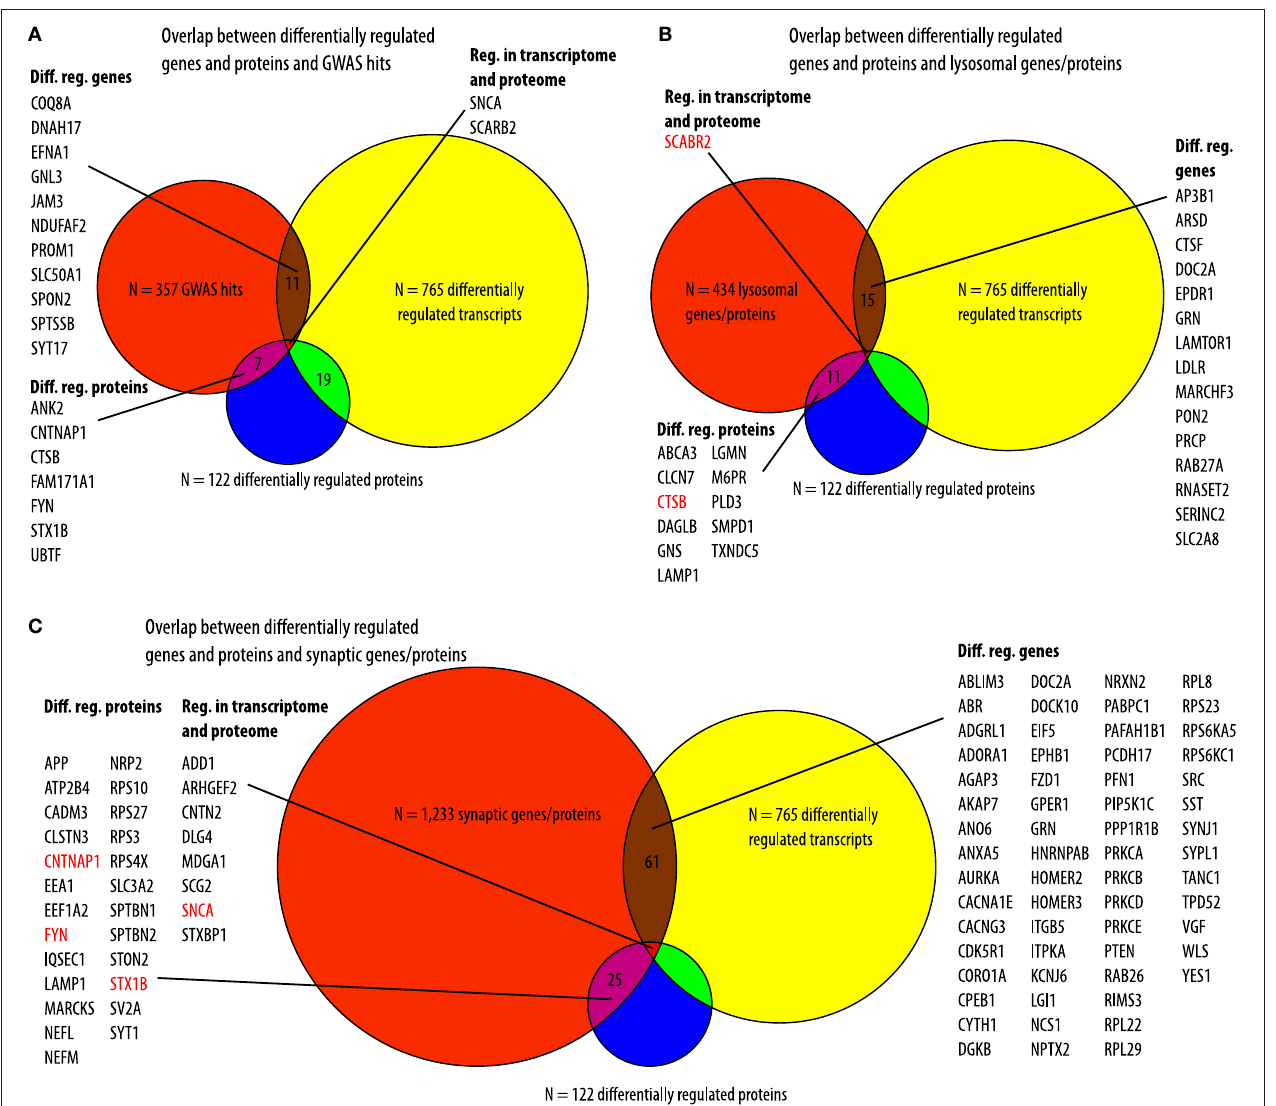
FIGURE 4 | Overlap to existing datasets. (A) Overlaps between N = 357 genes that were associated with risk loci in two recent Parkinson’s disease genome-wide associated studies (GWAS) (an orange circle) and transcripts (a yellow circle) and protein (a blue circle) that were differentially regulated in our cell model. Of the 357 genes associated with PD, N = 11 were differentially regulated in our cell model (a brown area). Furthermore, N = 7 proteins encoded by these genes were differentially regulated in our cell model (a pink area). In addition to SNCA (alpha-synuclein) that was overexpressed in our cells model, also SCARB2 (scavenger receptor Class B, Member 2) was regulated on the transcriptomic and proteomic level (a red area). (B) Overlap between N = 434 genes present in the human lysosome gene database (an orange circle) and differentially regulated genes (a yellow circle) or proteins (a blue circle) in our cell model. N = 15 of the 434 lysosomal genes were differentially regulated in our cell model (a brown area). N = 11 proteins that were present in the human lysosome gene database were differentially regulated in our cell model (a pink area). Red characters indicate genes/proteins (SCARB2, scavenger receptor class B, member 2; CTSB, cathepsin B) that were found in the recent GWAS meta-analyses. (C) Overlap between N = 1,233 synaptic genes (an orange circle) and genes (a yellow circle) or proteins (a blue circle) that were regulated in our cell model. N = 61 synaptic genes were differentially regulated in our cell model (a brown area). Furthermore, N = 25 of the proteins that were differentially regulated in our cell model were encoded by synaptic genes (a pink area). Red characters mark genes/proteins that have been found in the recent GWAS meta-analyses (FYN, FYN proto-oncogene, Src family tyrosine kinase; STX1B, syntaxin 1B). In addition to SNCA, 7 more genes/proteins were regulated on the transcriptomic and proteomic level in our cell model (a red area). Diff. reg., differentially regulated (adjusted p -value < 0.05, Benjanimi-Hochberg false discovery rate).